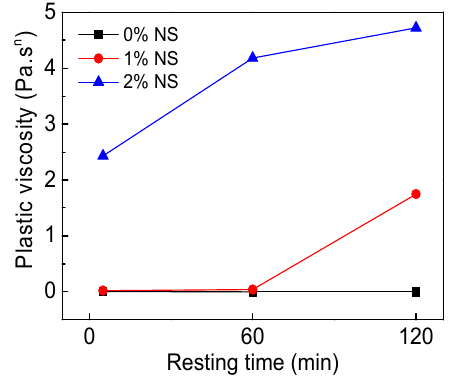
Figure 11. Influence of resting time on K.